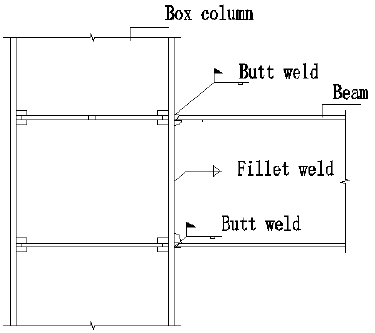
Figure 2. Beam ‐ to ‐ column connection. Figure 2. Beam-to-column